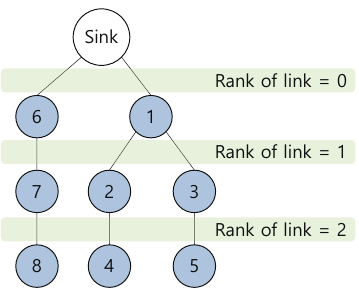
Figure 4. An example of the rank of